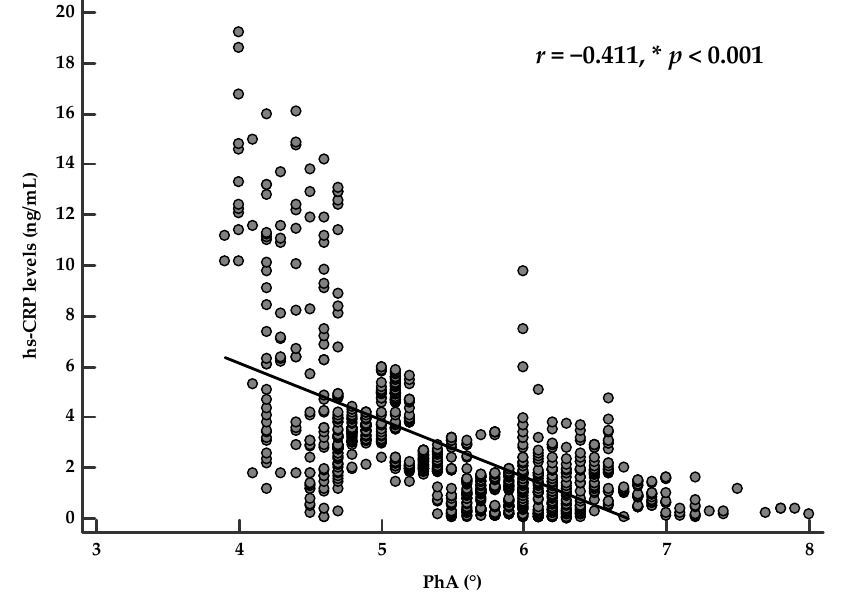
Figure 2. Correlation between PhA and inflammatory marker after adjusting for age, physical activity, BMI, WC, and PREDIMED score, in female participants. A * denotes a significant difference ( p <